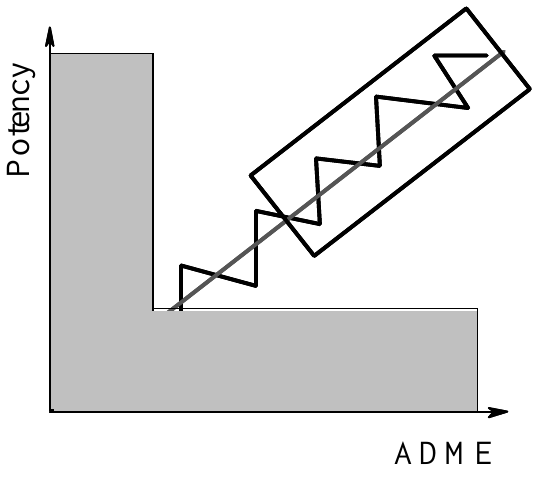
Figure 3. Third scenario: Binding affinity (potency) and ADME properties are optimised simultaneously.